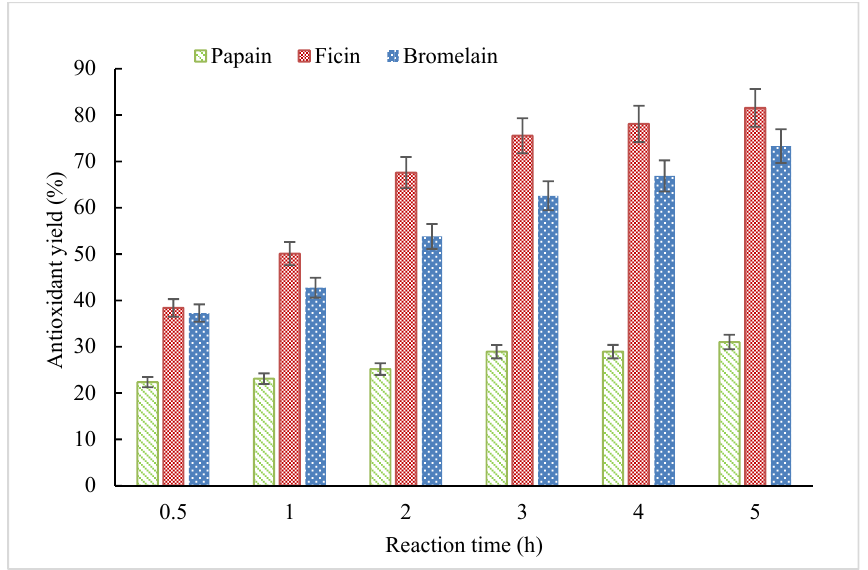
Figure 1. Antioxidant yield of corn gluten meal (CGM) hydrolysates with different reaction times prepared by papain, ficin, and bromelain.